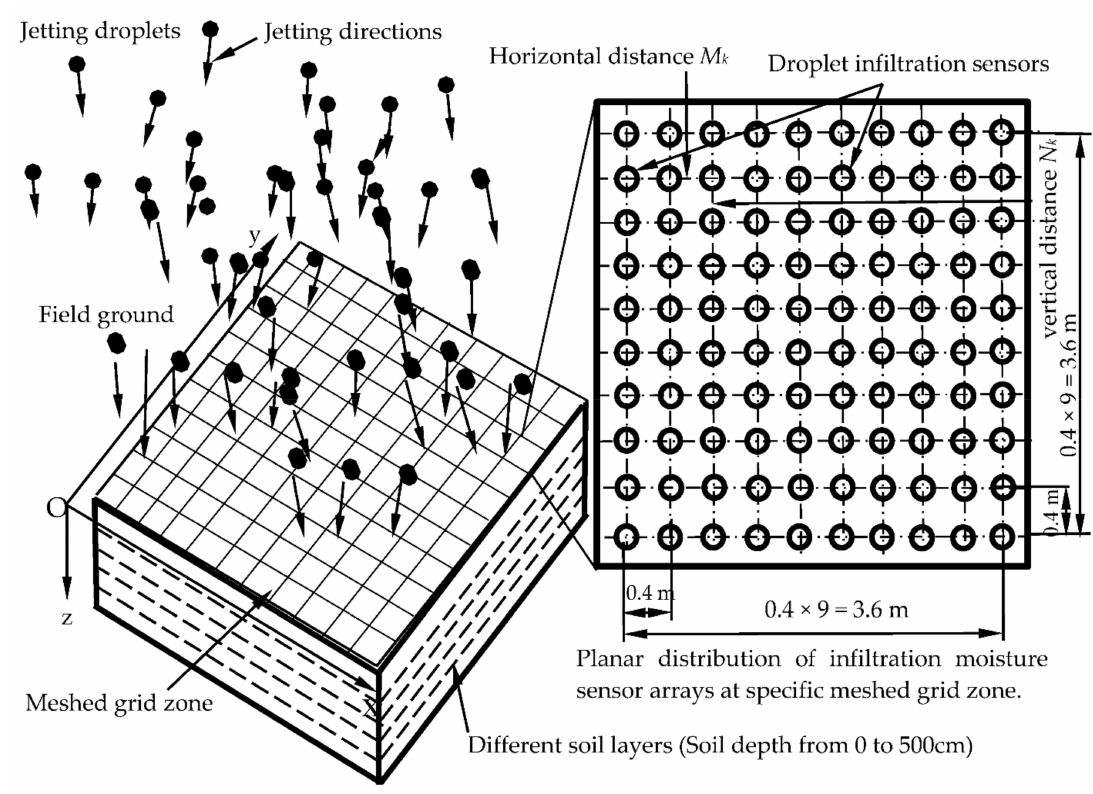
Figure 1. Water droplet infiltration of sprinkler irrigation and the planar meshed grid on soil field, used for the moisture gauging and position calibration of droplet infiltration